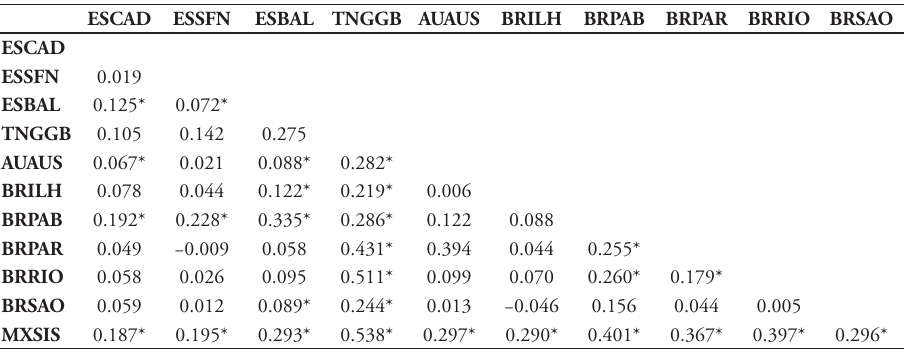
Table 4. Pairwise F values between populations of Paracaprella pusilla , based on mtDNA COI+16S ST sequences. Significant values ( p < 0.05) are indicated with an asterisk.